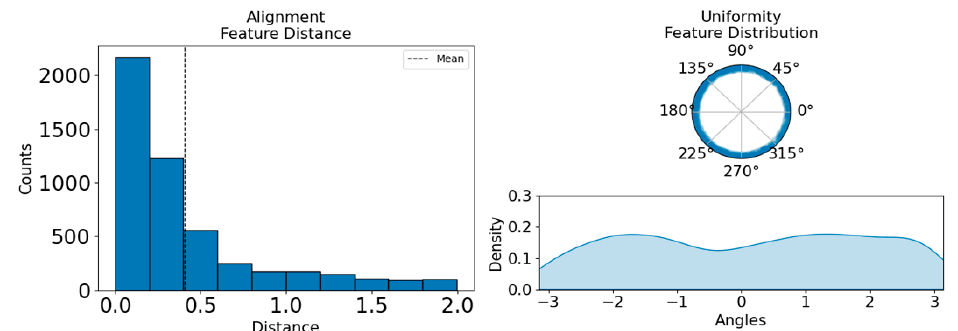
Figure 5. The method described in this article.